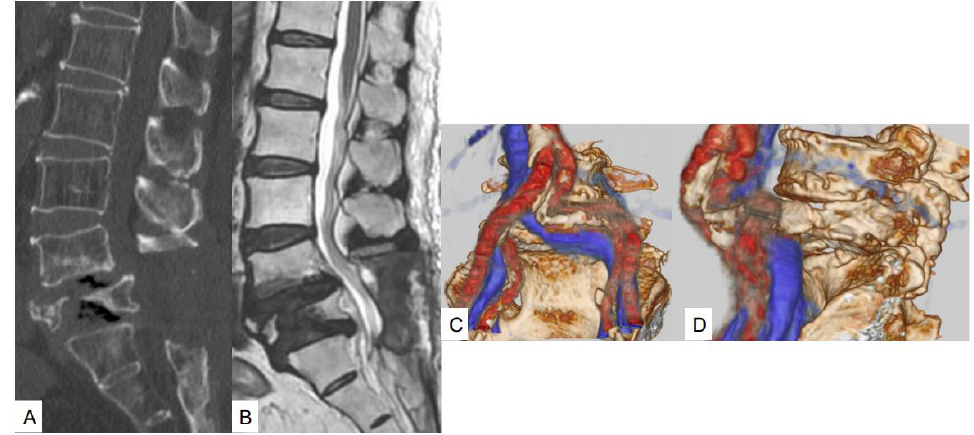
Figure 2. Images at the 9-month follow-up. ( A ) Mid-sagittal reconstruction CT; ( B ) Mid-sagittal T2-weighted image; ( C ) Anteroposterior 3D vascular image; ( D ) Lateral 3D vascular image.